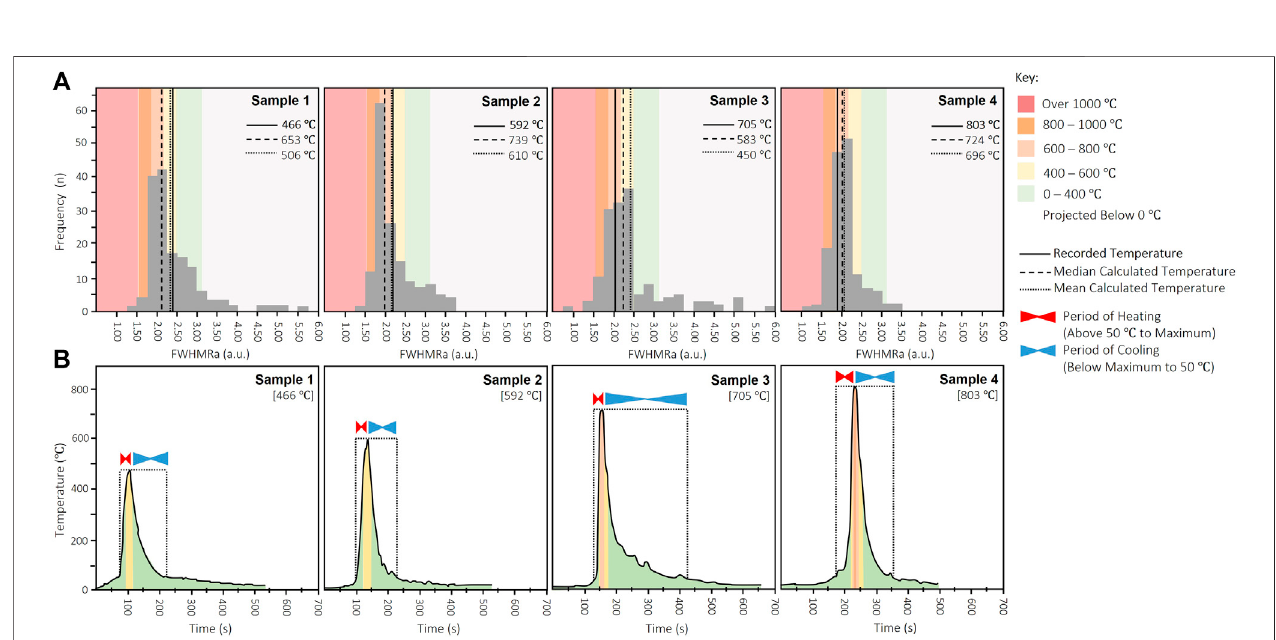
FIGURE 3 | Crossplots indicating the relationship between median Raman parameter values and the formation temperature of charcoals derived from prescribed fi re (dashed black line, open circle) and tube furnace pyrolysis (black line, fi lled circle), respectively. Each data point re fl ects median values from 150 individual spectral deconvolutions, with standard deviations for the experimentally pyrolyzed charcoal dataset shown by vertical black lines. Key in top left crossplot corresponds to all succeeding plots.